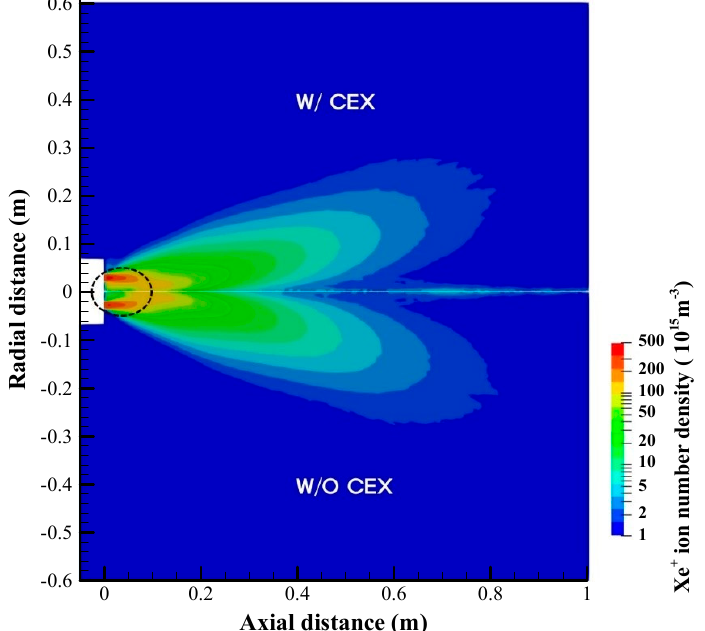
Figure 12. Contours of the Xe + ion number density (top: with CEX effects, bottom: without CEX effects).